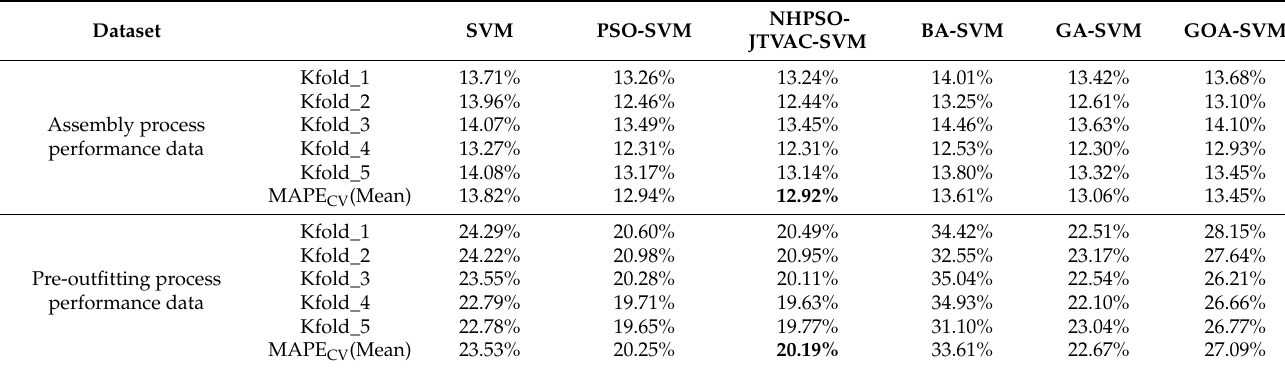
Table 5. K-fold CV scores (MAPE) of each model.